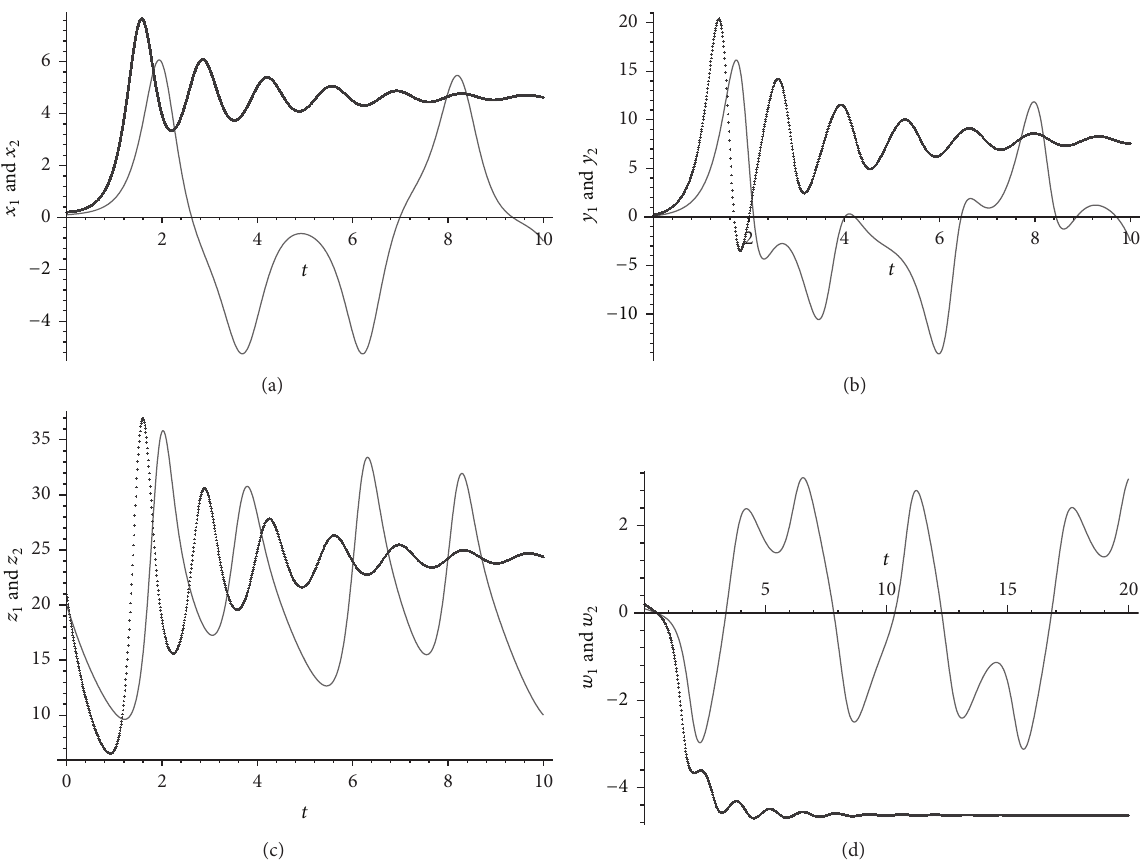
Figure 6: The solutions of the master and slave systems without active control law. (a) Signals 𝑥 1 (the dashed line) and 𝑥 2 (the solid line). (b) Signals 𝑦 1 (the dashed line) and 𝑦 2 (the solid line). (c) Signals 𝑧 1 (the dashed line) and 𝑧 2 (the solid line). (d) Signals 𝑤 1 (the dashed line) and 𝑤 2 (the solid